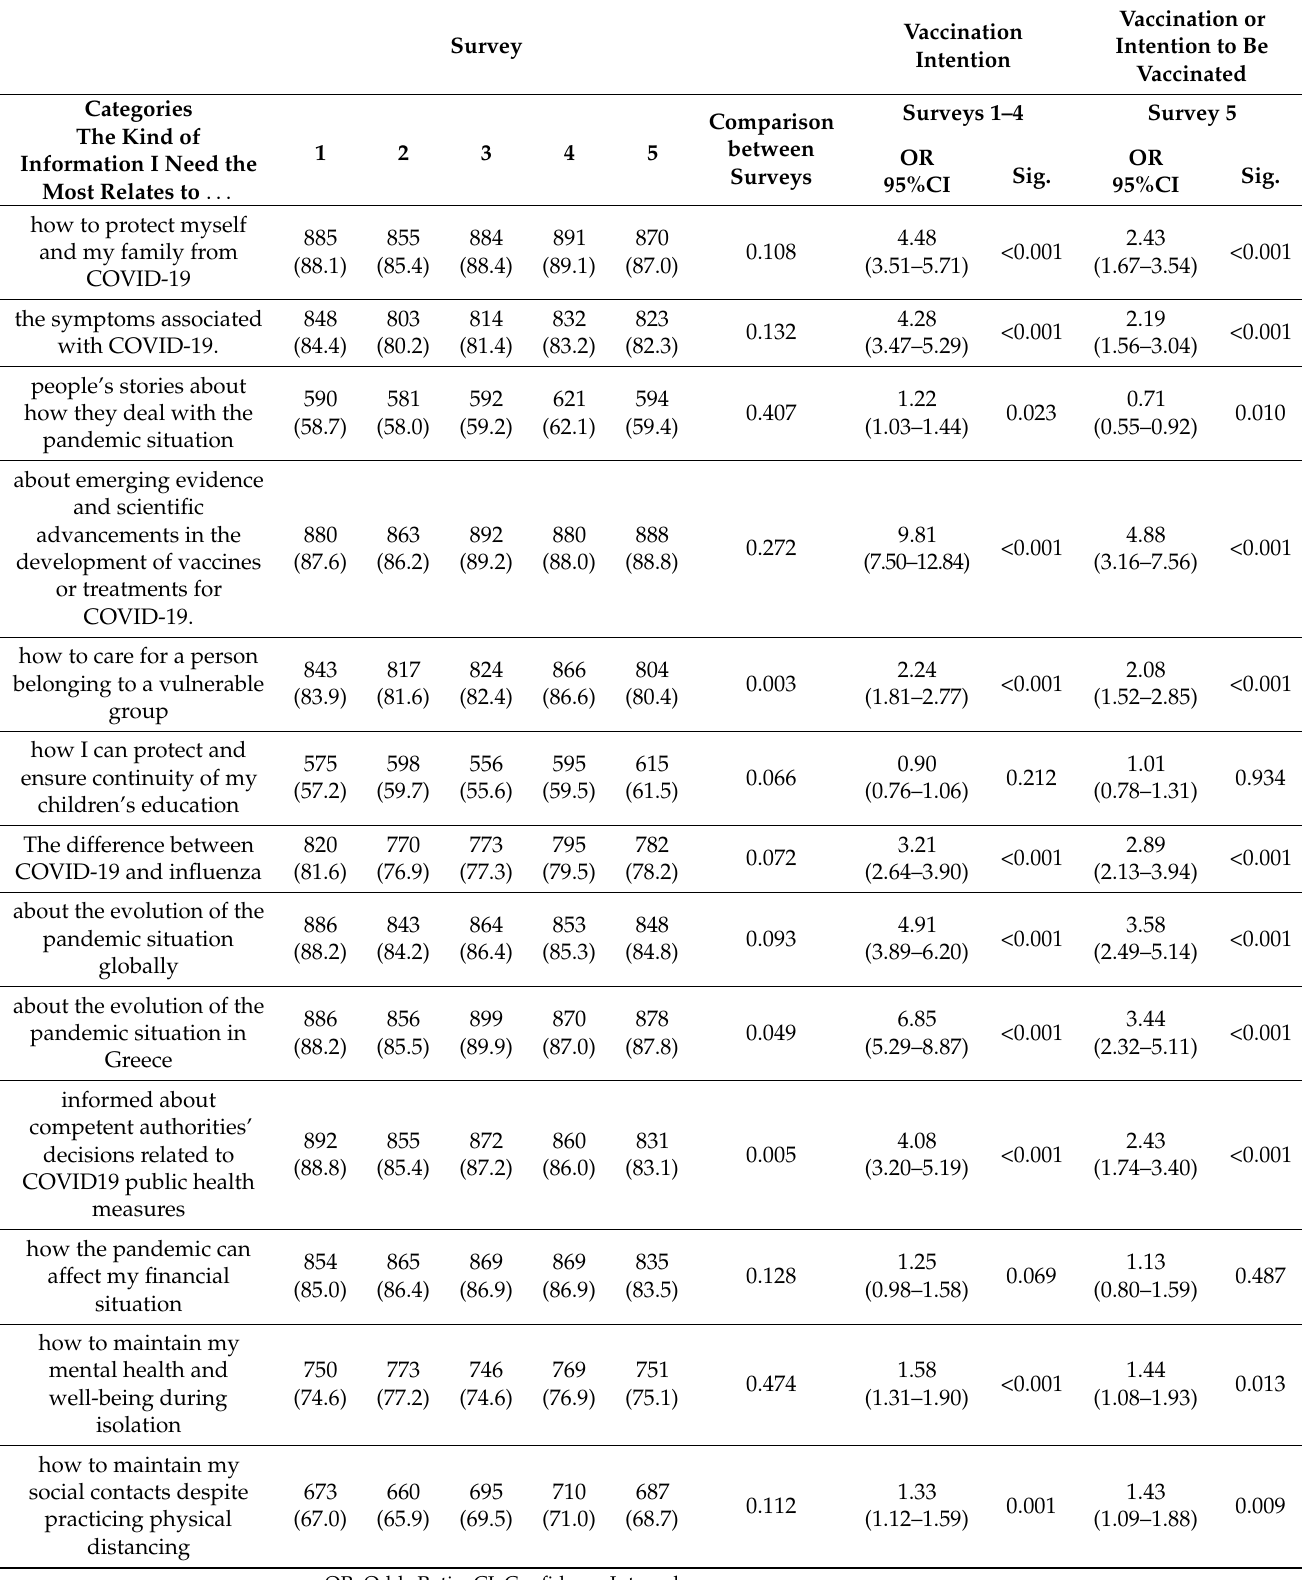
Table 3. Knowledge regarding the pandemic across the